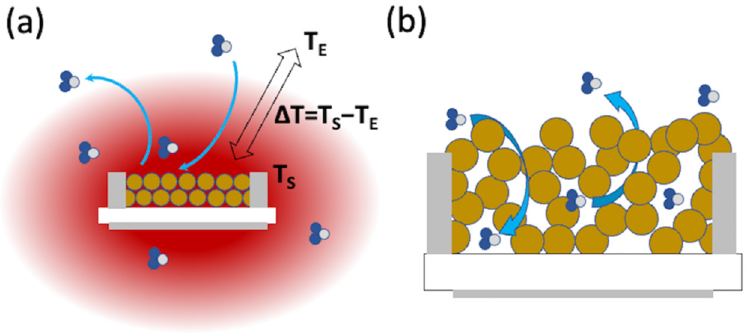
Figure 2. Schematic representation of diffusion phenomena occurring in proximity and through the metal oxide layer. ( a ) Diffusion through the temperature gradient surrounding sensors with an embedded heater owing to the difference between the sensor temperature (T S ) and the environment temperature (T E ); ( b ) diffusion through the pores of the metal oxide layer owing to the different gas concentrations in the environment and inside the sensing layer.